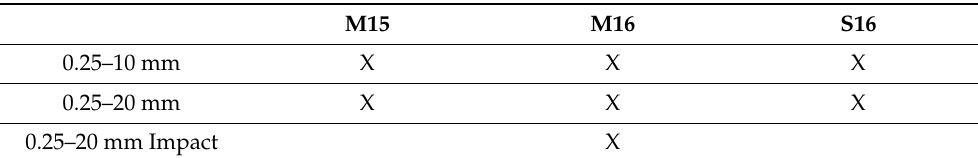
Table 1. Rapeseed straw size according to harvested